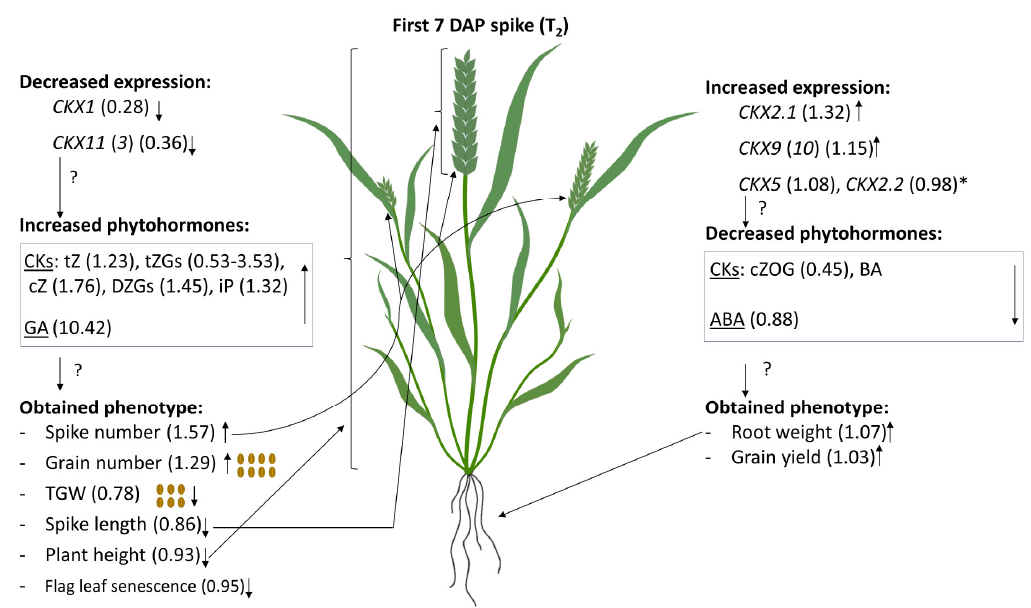
Figure 5. Graphic presentation of coordinated effect of TaCKX1 silencing on expression of other TaCKX genes, phytohormone levels as well as phenotype in 7 DAP spikes of T 2 plants based on ratio indicators. *—significantly increased comparing to T 1 ; ?—expected changes.